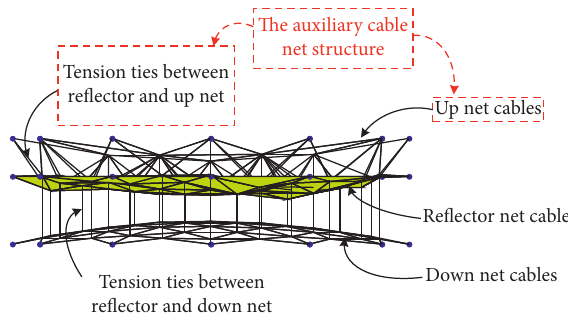
Figure 1: A 3-layered cable net structure with a mesh-shaped reflector. An auxiliary layer of cable net structure is added to the traditional 2-layered AstroMesh structure to realize the bidirec- tional force on the reflector.